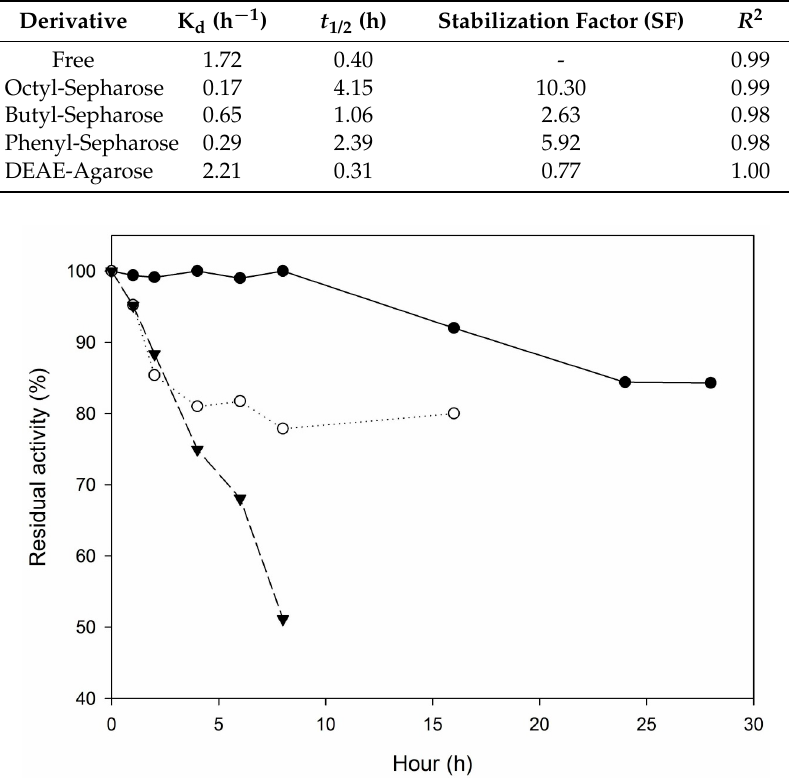
Figure 1. Octyl+PEI( (cid:72) ), Octyl+trehalose( )andCNBr-activatedSepharose( )derivativesthermalstability Figure 1. Octyl + PEI ( ▼ ), Octyl+trehalose ( ○ ) and CNBr-activated Sepharose ( ● ) derivatives thermal (cid:35) at60 ◦ C.Incubationwascarriedoutin5mMsodiumphosphatebuffer, pH7.0, stability at 60 °C. Incubation was carried out in 5 mM sodium phosphate buffer, pH 7.0, under non- reactive conditions.